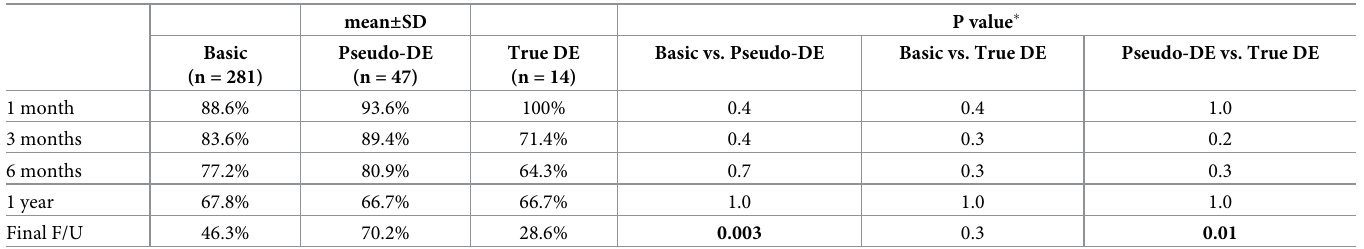
Table 5. Surgical success rates by intermittent exotropia